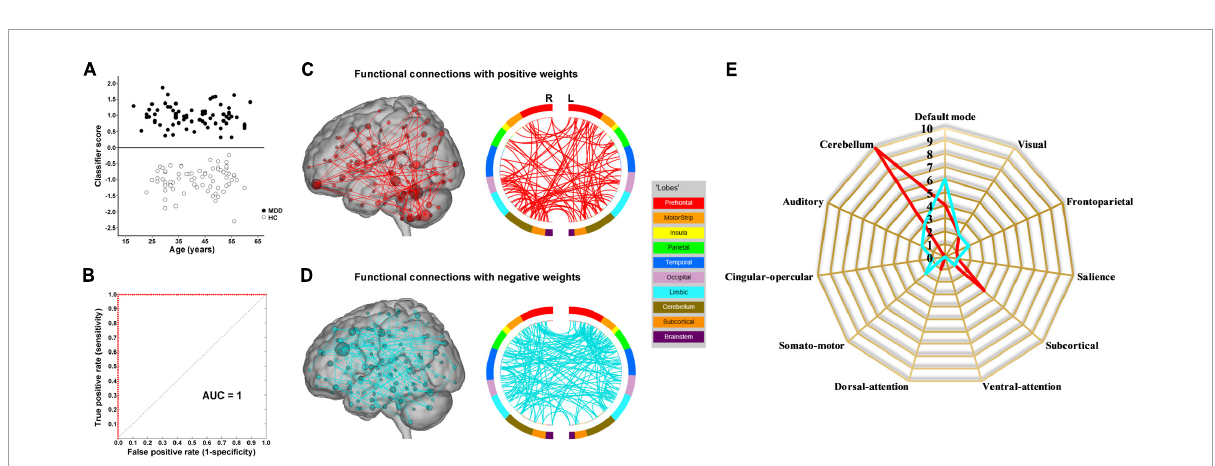
FIGURE4 Dynamic functional connectivity-based classification using fMRI data with global signal regression. (A) Scatter plot showing classification scores of all the subjects. (B) Receiver operating characteristic (ROC) curve of the classifier. (C) High-degree nodes (degree ≥ 3, larger spheres indicate nodes with higher degree) and their connections in the positive network. (D) High-degree nodes (degree ≥ 3) and their connections in the negative network. (E) Fingerprints of the 25 highest-degree nodes summarized by overlap with canonical neural